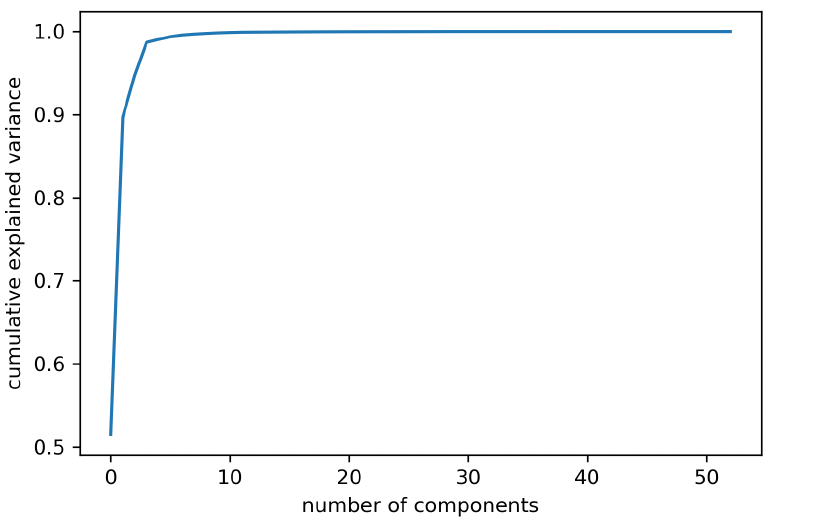
Figure A5. Principal component analysis in